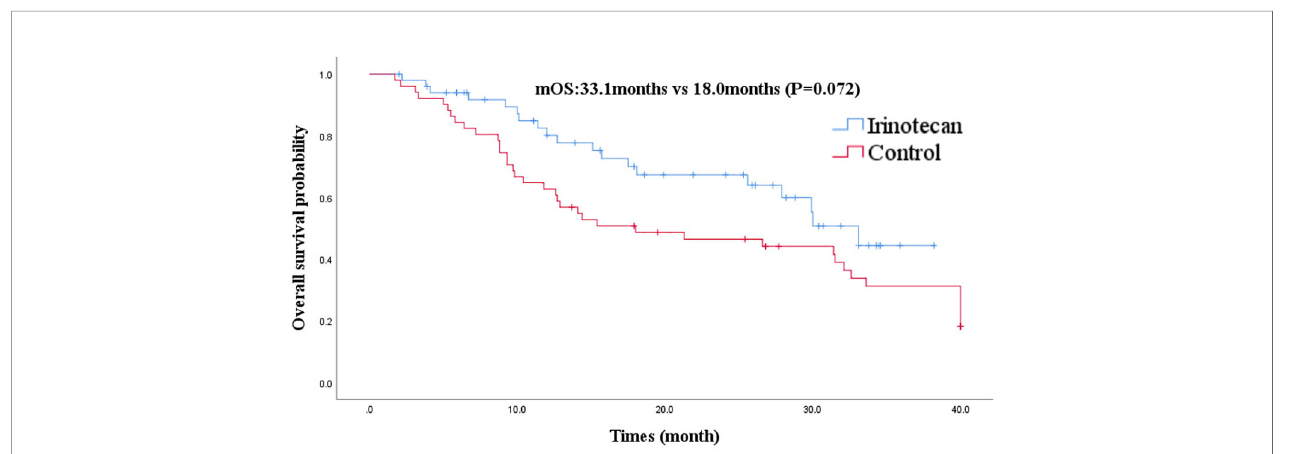
FIGURE 2 | Comparison of overall survival in irinotecan group and third-line overall survival in control group.